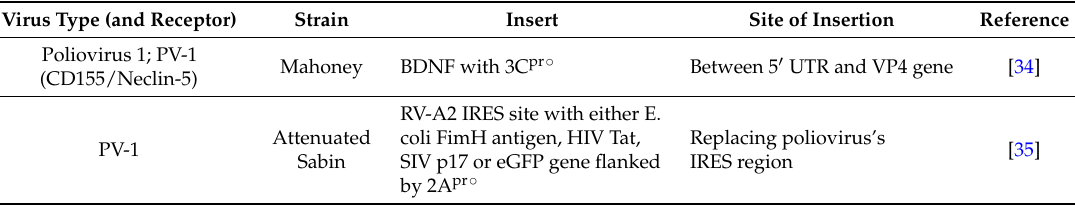
Table 1. Summary of enterovirus vectors and cloning